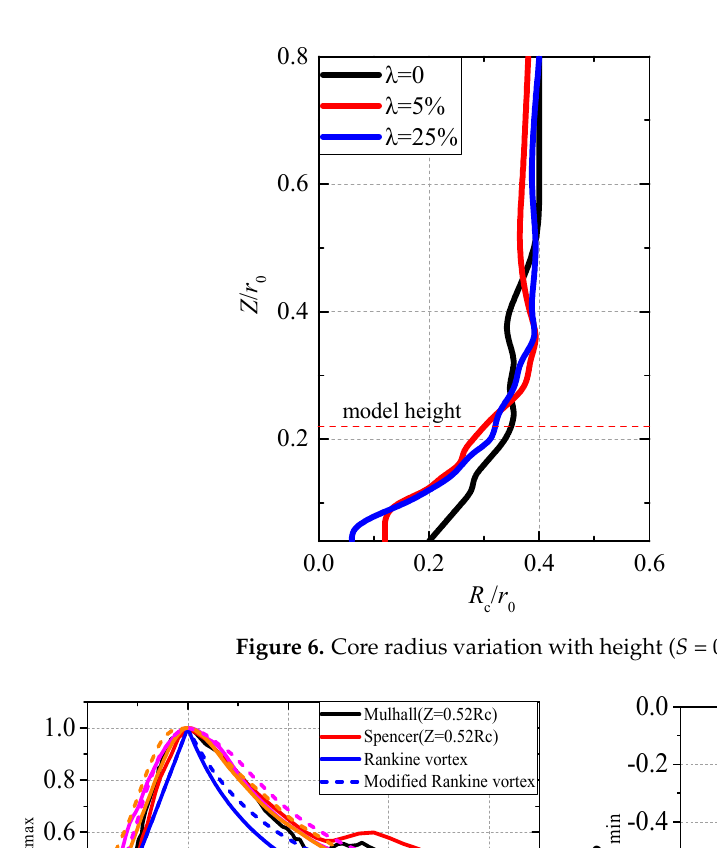
Figure 6. Core radius variation with height ( S = 0.35).